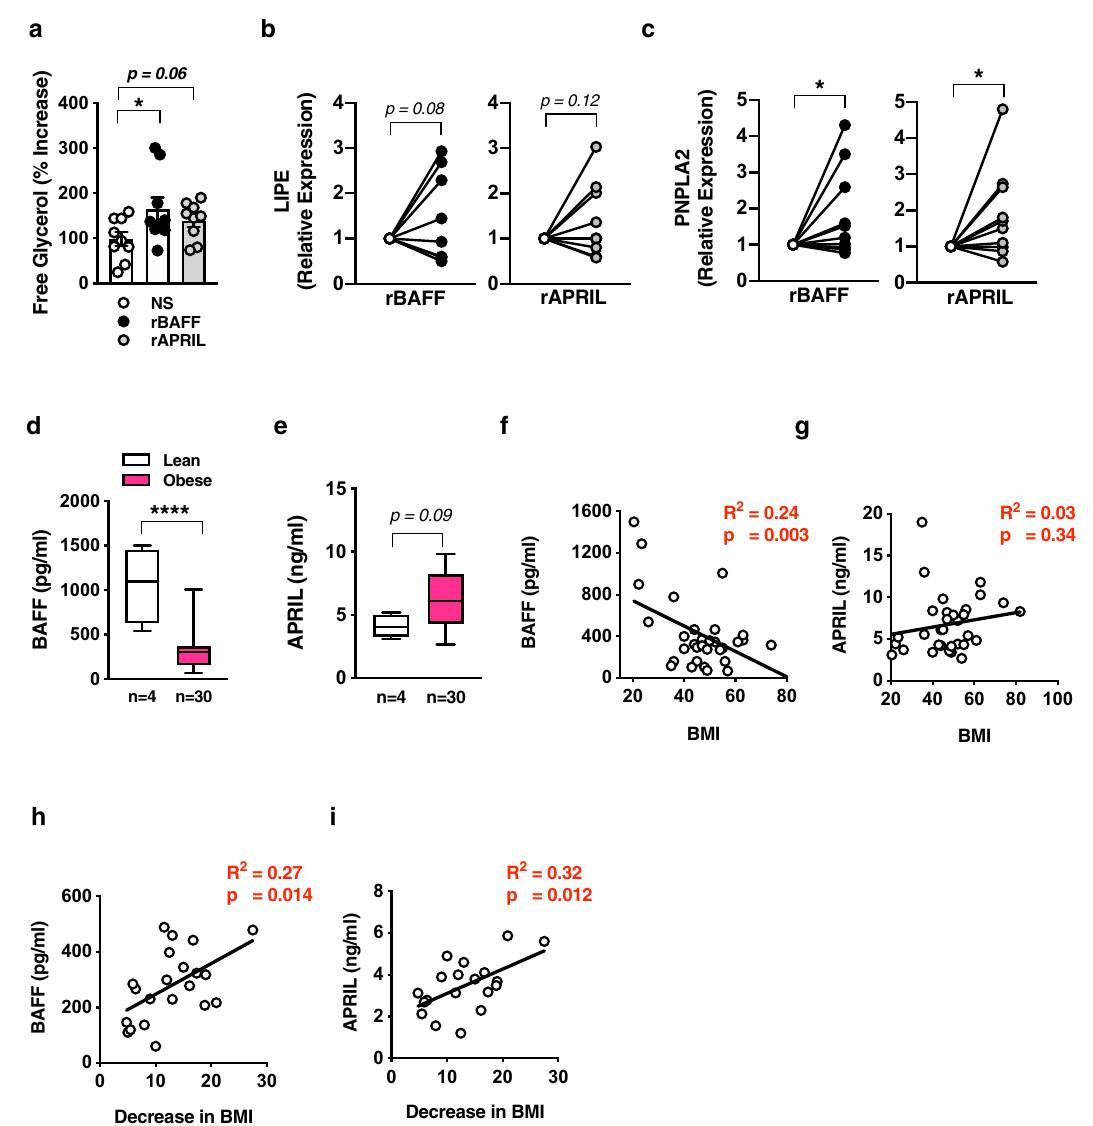
Fig. 7 Effect of BAFF and APRIL axis is conserved in human adipocytes. a – b Human primary adipocytes isolated from persons undergoing bariatric surgery. Adipocytes were treated with saline (NS), rBAFF (500 ng/ml), or rAPRIL (500 ng/ml) for 24 hours as indicated. a Supernatant free glycerol quanti fi ed by colorimetric assay. b LIPE mRNA expression quanti fi ed by qPCR, normalized to NS. c PNPLA2 mRNA expression quanti fi ed by qPCR, normalized to NS. d BAFF and e APRIL systemic concentration in lean or obese persons quanti fi ed by multiplex. f BAFF and g APRIL systemic concentration correlation with BMI. h BAFF and i APRIL systemic concentration correlation with decrease in BMI 1-year after bariatric surgery. a – c Representative persons, n = 9 – 10/condition. d – g Representative patients, n = 4 lean and n = 30 obese. h – i Data combined, n = 22 persons undergoing bariatric surgery. a – c For bar and line graphs, data represents mean±SEM. d – e For box plots, the midline represents the mean, boxes represent the interquartile range and whiskers show the full range of values. a – e Unpaired two-tailed Student ’ s t test. a , c , d * p < 0.05, **** p < 0.0001. f – i Linear regression. Source data are provided as a Source data fi